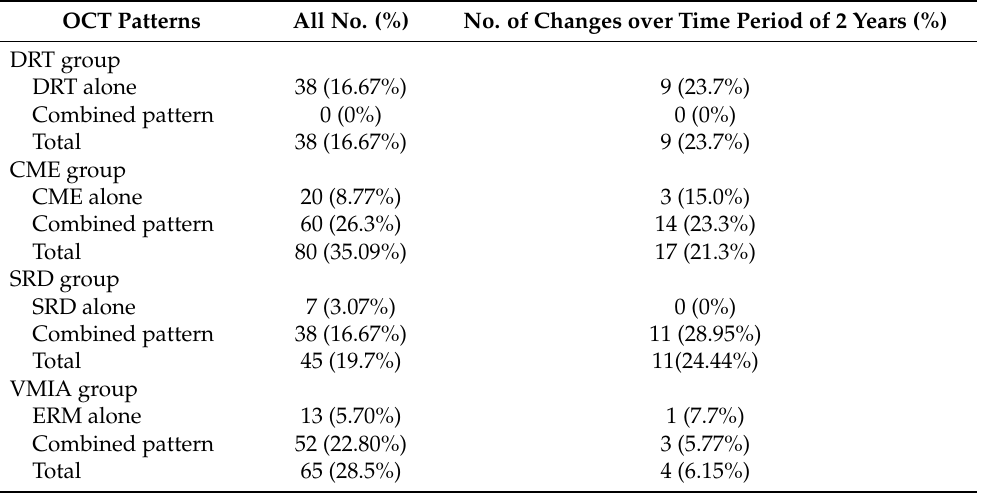
Table 2. Combinations of morphological subtypes and changes over time period of 2